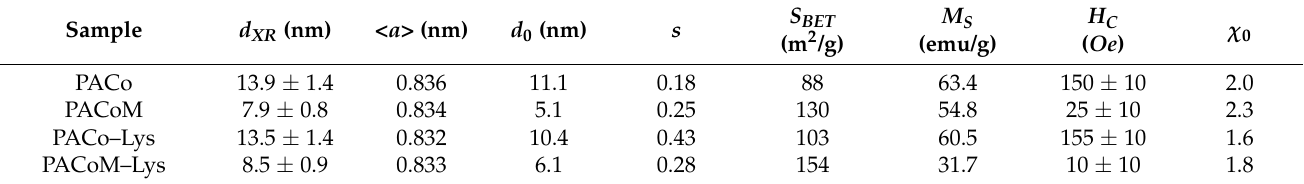
Table 1. Parameters of samples characterization: mean characteristic sizes ( d XR , d 0 ), cell